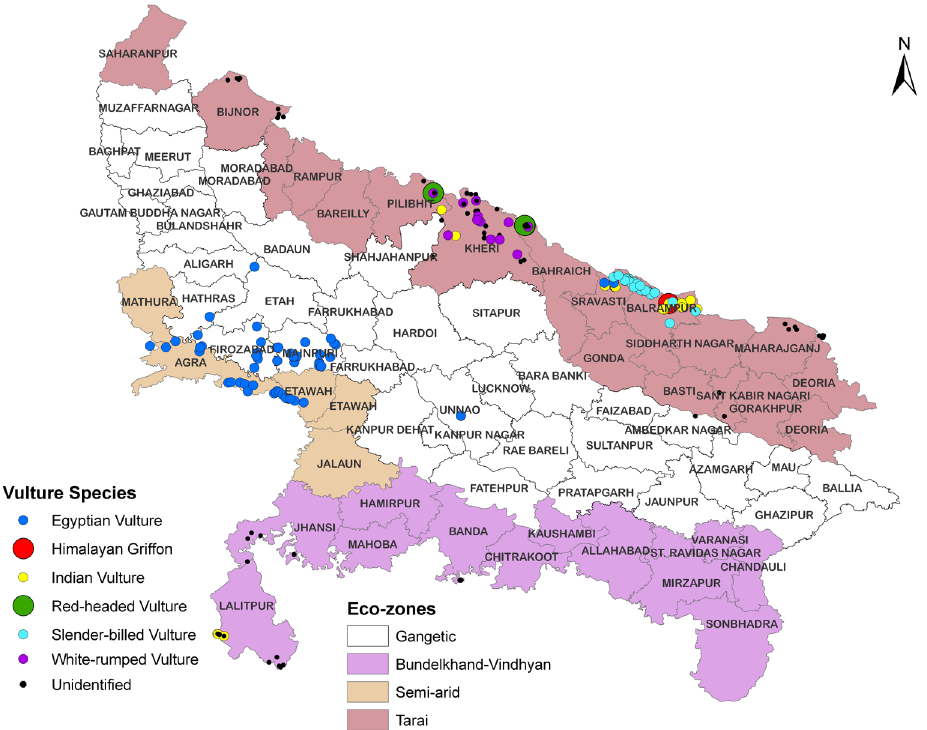
Figure 3. GPS data based locations of different vultures in different eco-zones of